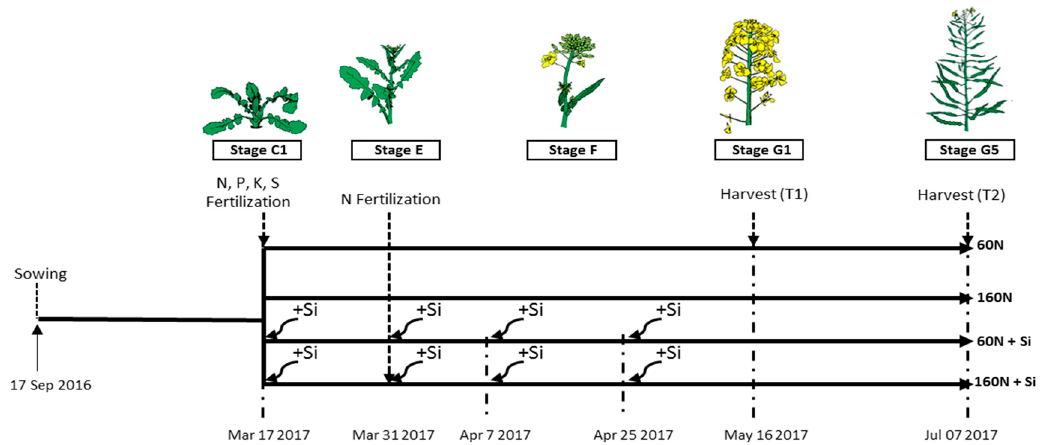
Figure 1. Experimental design used to study the effect of silicon (Si) on the agronomic performance of Brassica napus L. cultivated into lysimeter boxes. When plants were at stage C1 (March 17, 2017), fertilization combining nitrogen (N: 30 or 80 kg ha − 1 for 60 and 160 N treatments, respectively), phosphorus (P: 50 kg ha − 1 ), potassium (K: 50 kg ha − 1 ) and sulfur (S: 30 kg ha − 1 ) was applied. At stage E (March 31 2017), a second N fertilization with 30 or 80 kg N ha − 1 was applied to the 60 and 160 N treatments, respectively. In addition, for each N treatment (60 and 160 N), fertilization with Si (Si: 12 kg ha − 1 as Si(OH) 4 ) was applied in four times (March 17 and 31 and April 7 and 25 2017: 60 N + Si and 160 N + Si) or not (controls: 60 N and 160 N). For all treatments, plants were harvested at T1 and T2 corresponding to the G1 and G5 stages, respectively.